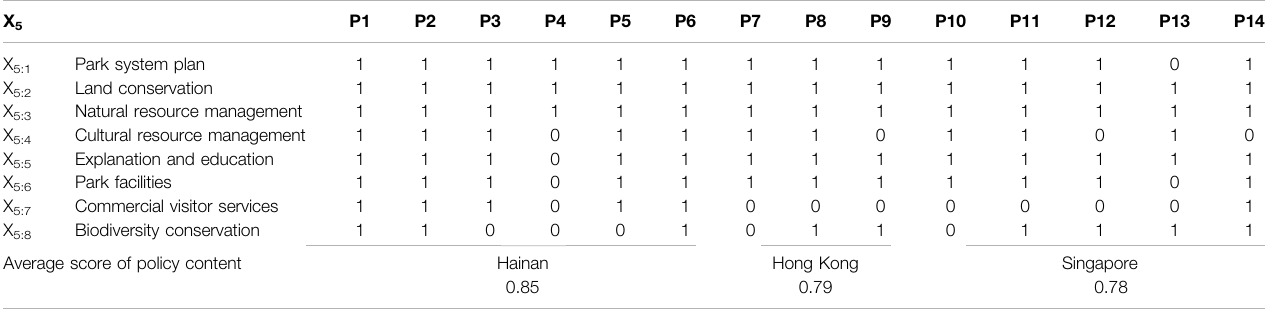
TABLE 10 | Policy content of Hainan Tropical Rainforest National Park needs further